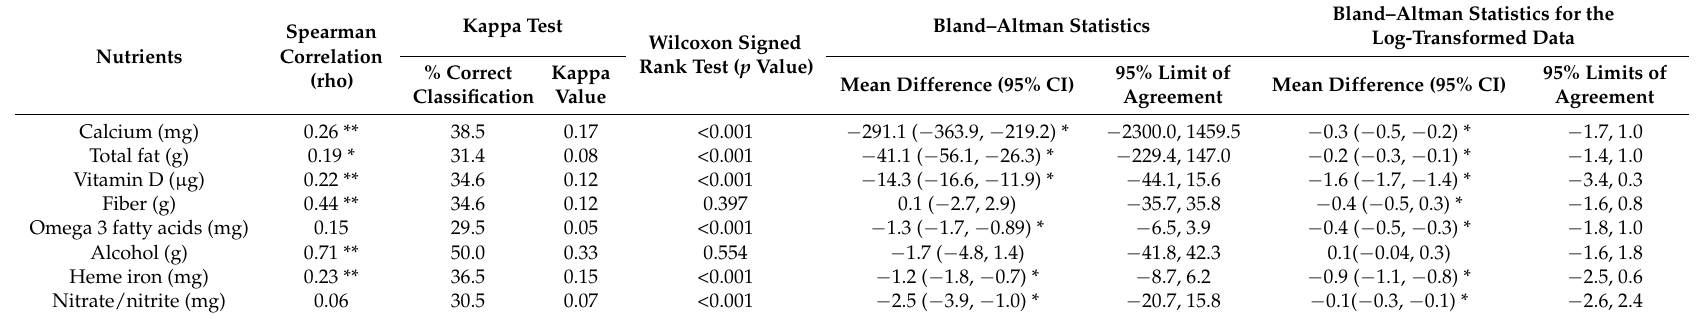
Table 5. Validity of nutrient intake: Spearman correlation, Kappa test, Wilcoxon signed rank test, and Bland-Altman statistics ( n =